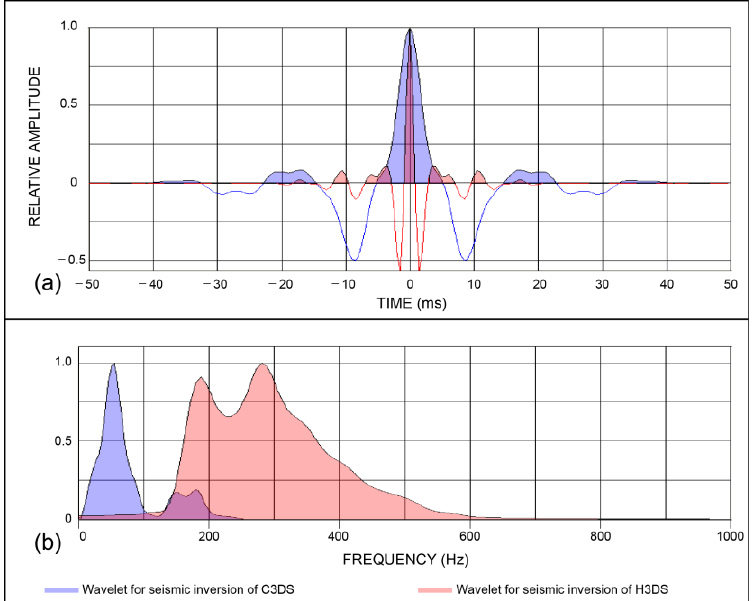
Figure 5. ( a ) Two wavelets extracted from C3DS and H3DS. ( b ) Amplitude spectra for the two wavelets shown in ( a ).